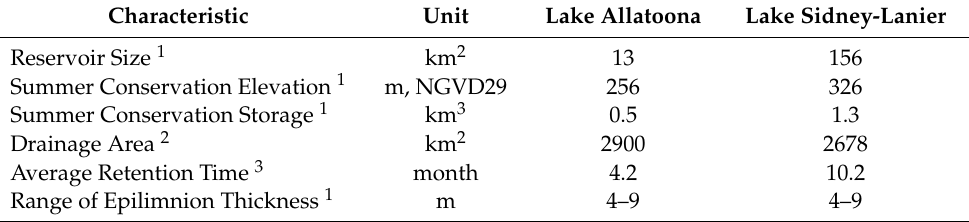
Table A1. The physical and hydrological characteristics of Lakes Allatoona and Sidney-Lanier and their watersheds show that Allatoona drains a larger acreage per reservoir area than Lanier, resulting in a shorter retention time.